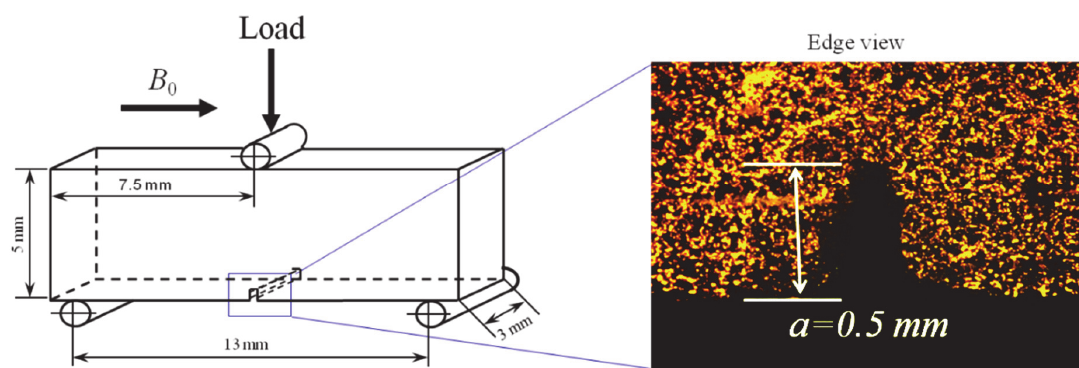
Figure 1: Specimen’s geometry and edge micrograph of the introduced